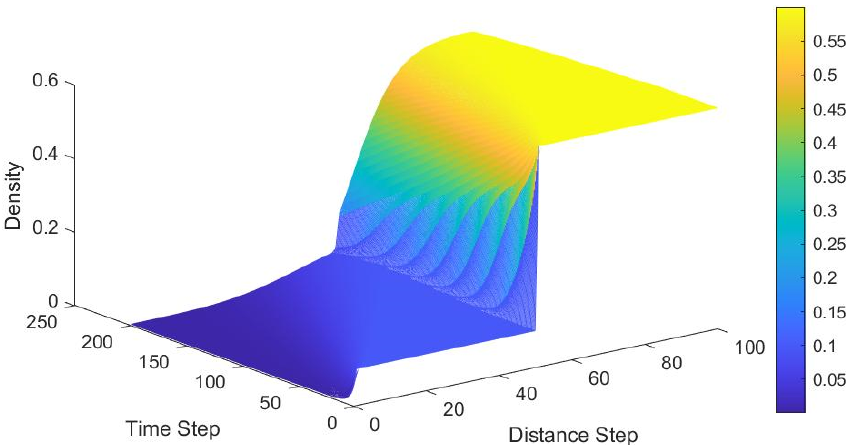
Figure 10. Velocity behavior of PW model on straight road with no ingress traffic.